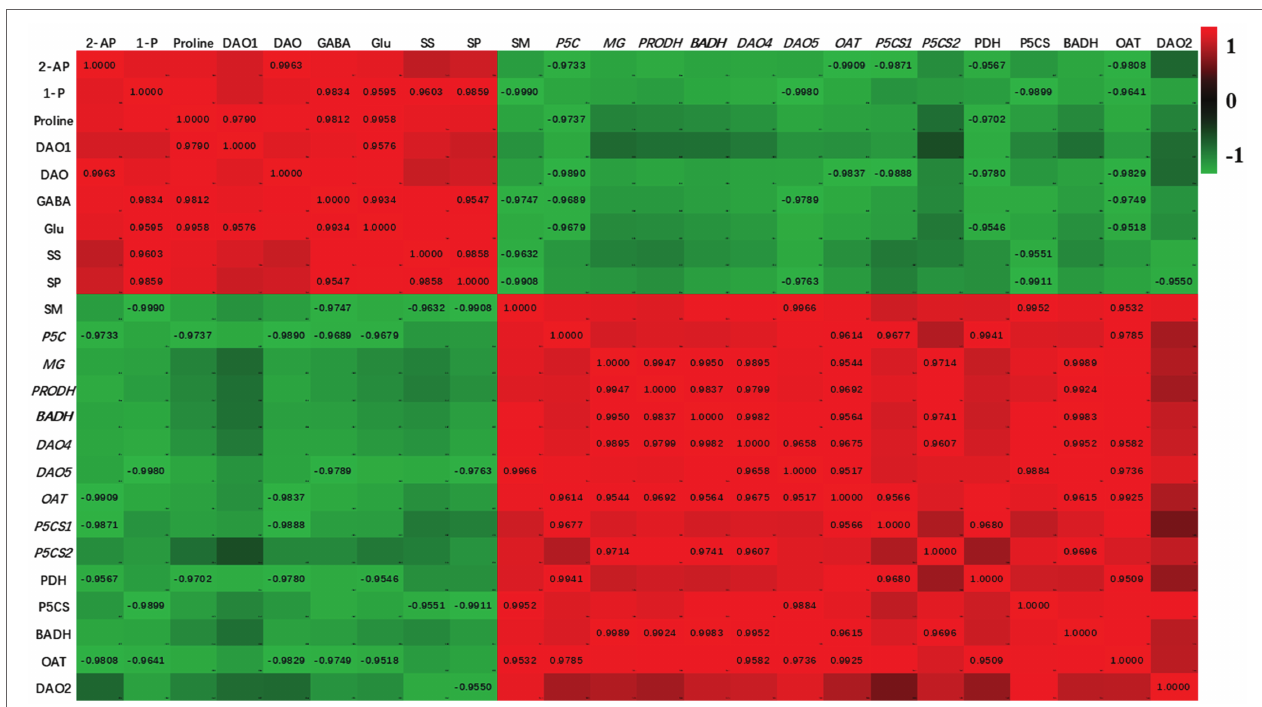
FIGURE 6 | The heatmap for the investigated parameters. Values are fit constants (only show when p < 0.05). 2-AP, 2-acetyl-1-pyrroline; SM, soil moisture content; 1-P, 1-pyrroline content; MG, methylglyoxal content; SP, soluble sugar content; Glu, glutamic acid content: SS, soluble sugar content; P5C, pyrroline-5-carboxylic acid;